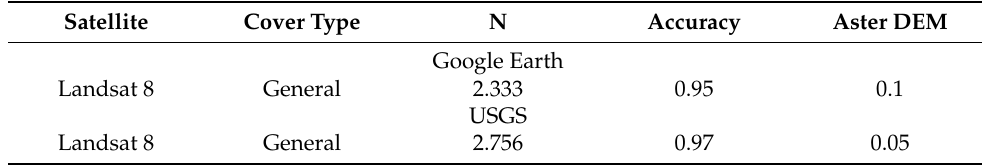
Table 1. Satellite recordings properties used in this research. Satellite Cover Type N Accuracy Aster DEM Google Earth Landsat 8 General 2.333 0.95 0.1 USGS Landsat 8 General 2.756 0.97